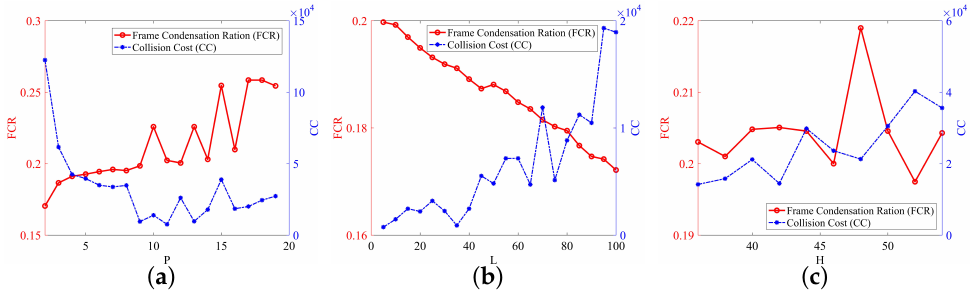
Figure 4. Frame compact ratio (FCR) and collision cost (CC) as a function of ( a ) container capacity P , ( b ) the lower bound L , and ( c ) the upper bound H